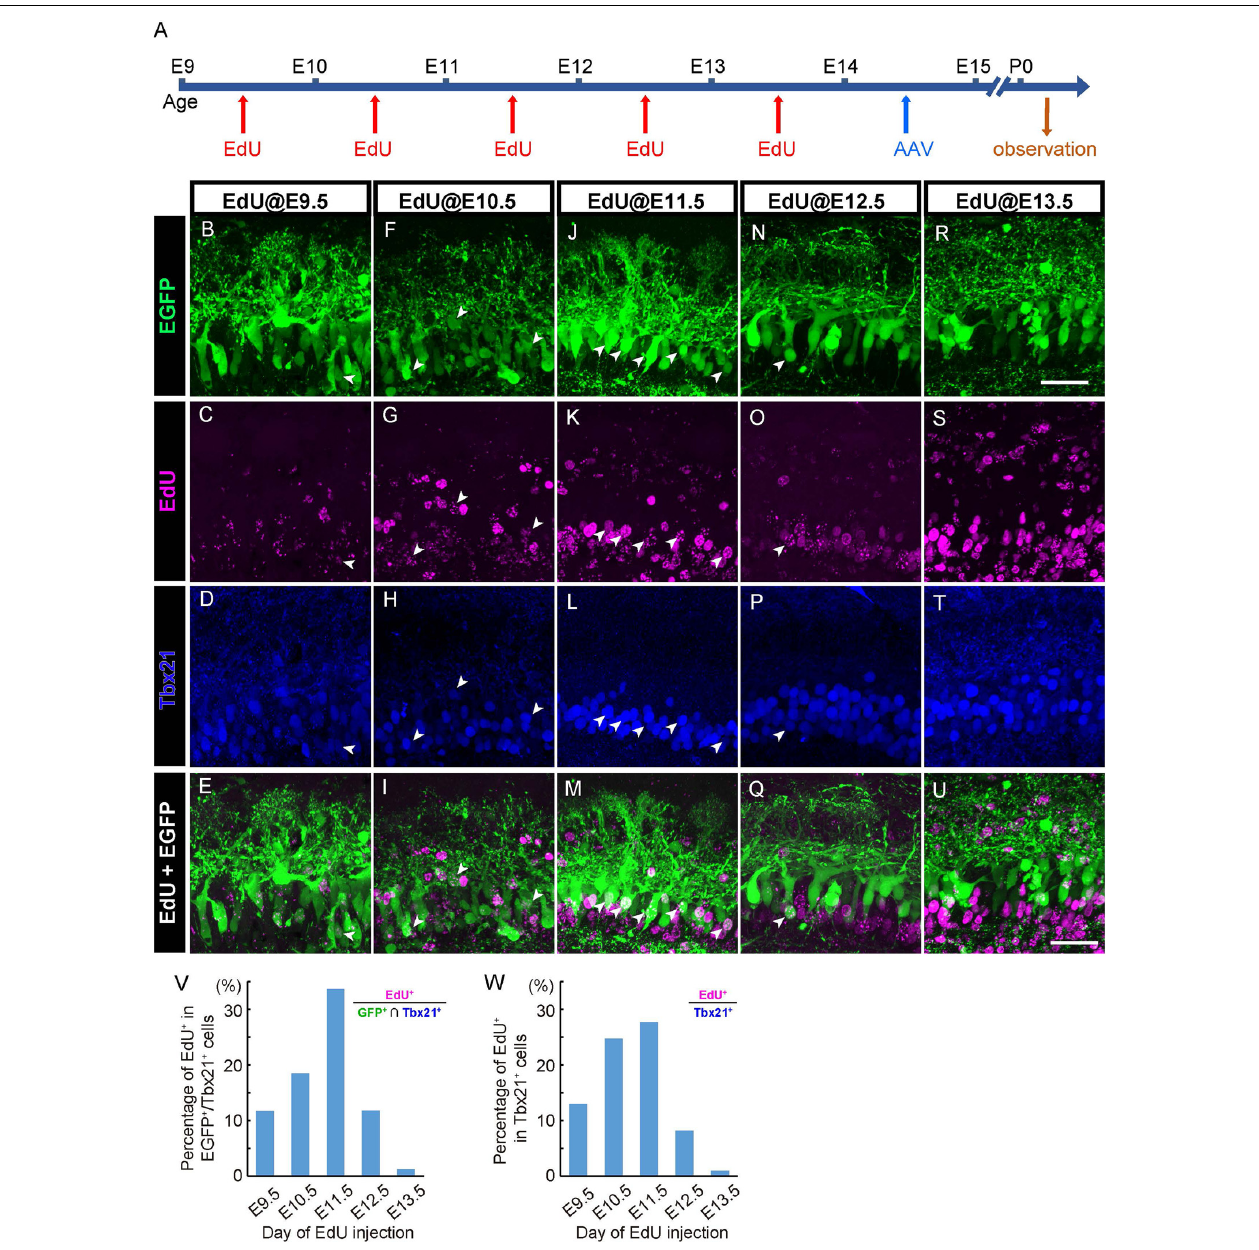
FIGURE 3 | AAV transduces mitral cells independently of birthdates. (A) The diagram shows the time course of EdU and AAV injection, and preparation. (B–U) Each column corresponds to the timing of EdU injection (E9.5, E10.5, E11.5, E12.5, and E13.5, respectively). Immunohistochemistry against EGFP ( B,F,J,N , and R , green) and EdU ( C,G,K,O , and S , magenta) were examined with Tbx21 ( D,H,L,P , and T , blue) detection at P0. EdU + cells of EGFP + /Tbx21 + cells are indicated by arrowheads. Merged images (EGFP and EdU) are shown at the bottom ( E,I,M,Q , and U ). ( V,W ) The timing of administration of EdU and the ratio of EdU-labeled cells in EGFP-positive and Tbx 21 positive cells (V) . The numbers of mice analyzed are 1, 1, 3, 1, and 3 for E9.5, E10.5, E11.5, E12.5, and E13.5, respectively. The timing of administration of EdU and the ratio of EdU-labeled cells in Tbx21-positive cells (W) . The numbers of mice analyzed are 1, 2, 2, 2, and 2 for E9.5, E10.5, E11.5, E12.5, and E13.5, respectively. All pups examined in these studies were selected based on GFP labeling under fluorescence dissection microscopy when we fixed and extracted the brain, and thus sex was not determined. Scale bar, 100 µ m.